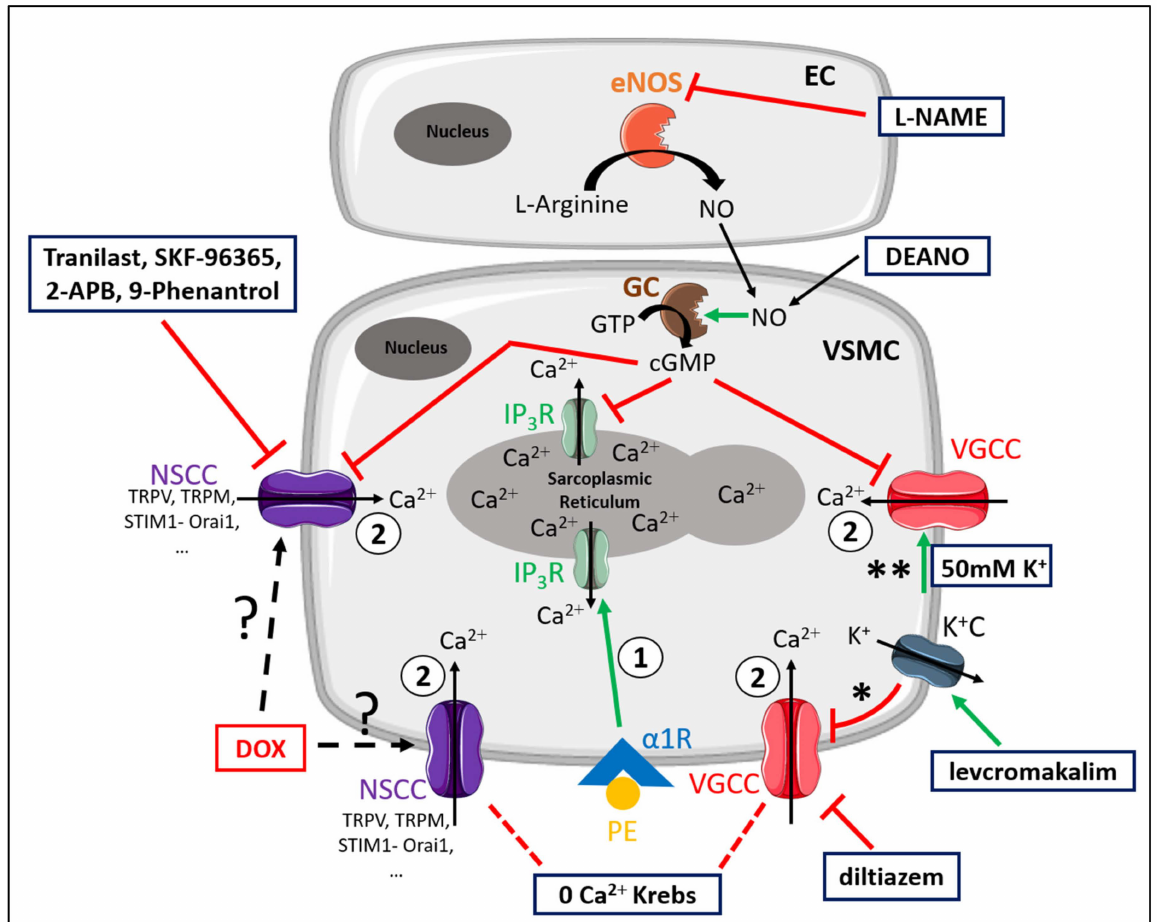
Figure 7. Schematic representation of the PE-elicited VSMC contraction response, including the compounds used to delineate the mechanisms of reduced VSMC contraction after DOX treatment. VSMC contraction through stimulation of α 1-adrenergic receptors ( α 1R) with PE is characterised by two components—namely, a fast transient contraction (event 1) and a concomitant tonic contraction (event 2) [26]. Event 1: The fast transient contraction is determined by inositol trisphosphate (IP 3 )-mediated release of Ca 2+ from the sarcoplasmic reticulum through IP 3 receptors (IP 3 R) [26]. Event 2: The concomitant tonic contraction is determined by Ca 2+ influx via VGCCs and NSCCs [26]. In both phases, cytoplasmic Ca 2+ content increases, thereby forming a Ca 2+ –calmodulin complex [31], which activates the myosin light chain kinase, promotes the binding of actin to myosin and thus initiates contraction [31]. Production of NO in ECs inhibits Ca 2+ release from the sarcoplasmic reticulum and VGCC- and NSCC-mediated Ca 2+ influx in a cyclic guanosine monophosphate (cGMP)-dependent way, thereby continuously diminishing contraction [30]. This eNOS-mediated NO production can be inhibited by L-NAME. A 0 mM Ca 2+ Krebs environment prevents Ca 2+ influx, which results in exclusively IP 3 -mediated contraction. Diltiazem actively inhibits VGCCs, thereby inhibiting VGCC-mediated Ca 2+ influx. Levcromakalim activates ATP-dependent K + channels (K + C), resulting in K + efflux, thereby causing a hyperpolarisation (event *) of the resting membrane potential and consequently deactivating VGCCs. In the presence of 50 mM K + , depolarisation will occur (event **), which will promote VGCC-mediated Ca 2+ influx and subsequently leads to VSMC contraction. DEANO acts as an exogenous NO donor and inhibits VGCCs and NSCCs in a manner similar to NO. Members of the diverse family of NSCCs are TRPV, TRPM, STIM1-Orai1, channels, which can be inhibited with tranilast, SKF-96365, 2-APB and 9-phenantrol. DOX may interfere with these channels through an unclear mechanism. Red lines represent inhibition or deactivation, while green lines correspond to activation or